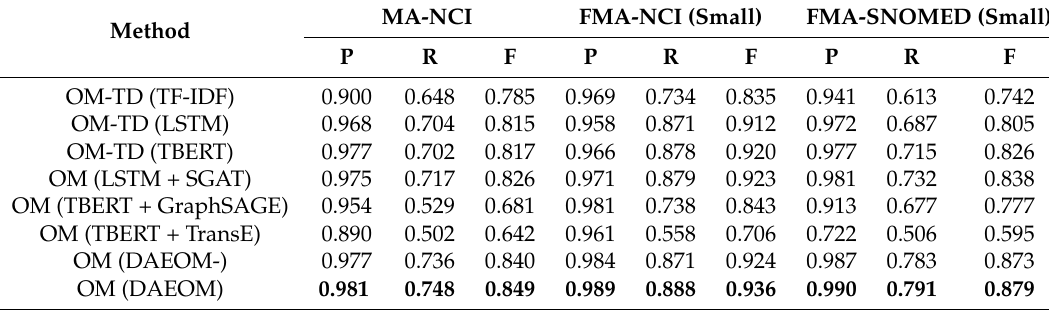
Table 2. The comparison of DAEOM with baseline